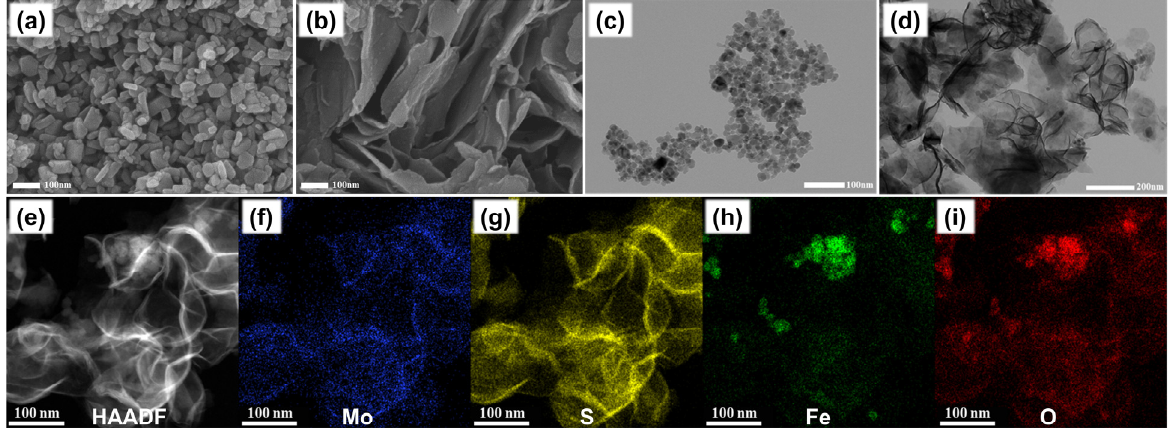
Figure 1. SEM images of ( a ) Fe 3 O 4 and ( b ) Fe 3 O 4 @MoS 2 ; TEM images of ( c ) Fe 3 O 4 and ( d ) Fe 3 O 4 @MoS 2 ; ( e ) HAADF image of Fe 3 O 4 @MoS 2 ; and corresponding element mapping of ( f ) Mo, ( g ) S, ( h ) Fe, and ( i )